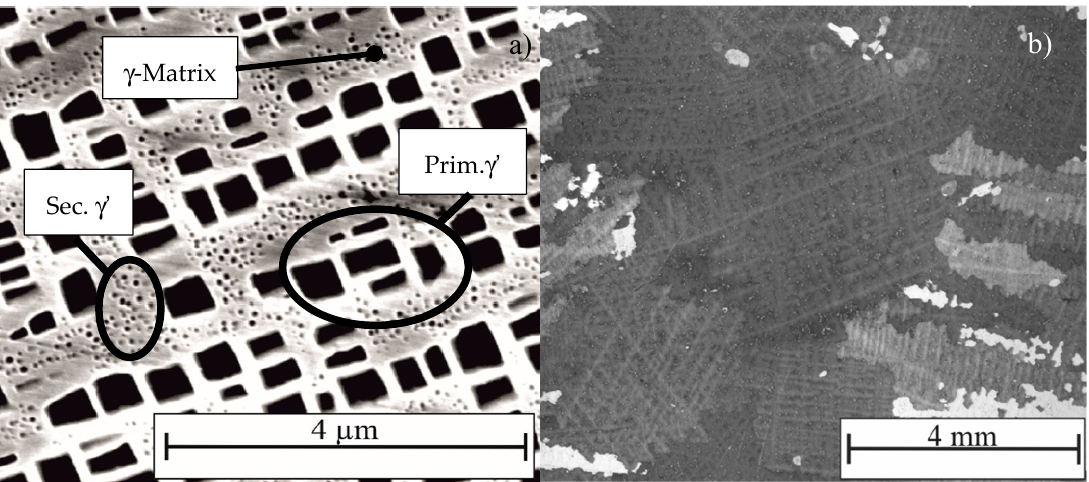
Figure 3. ( a ) Scanning electron microscope (SEM) image of the γ , γ ’microstructure; ( b ) light microscope image of cross section shows dendritic grain growth.